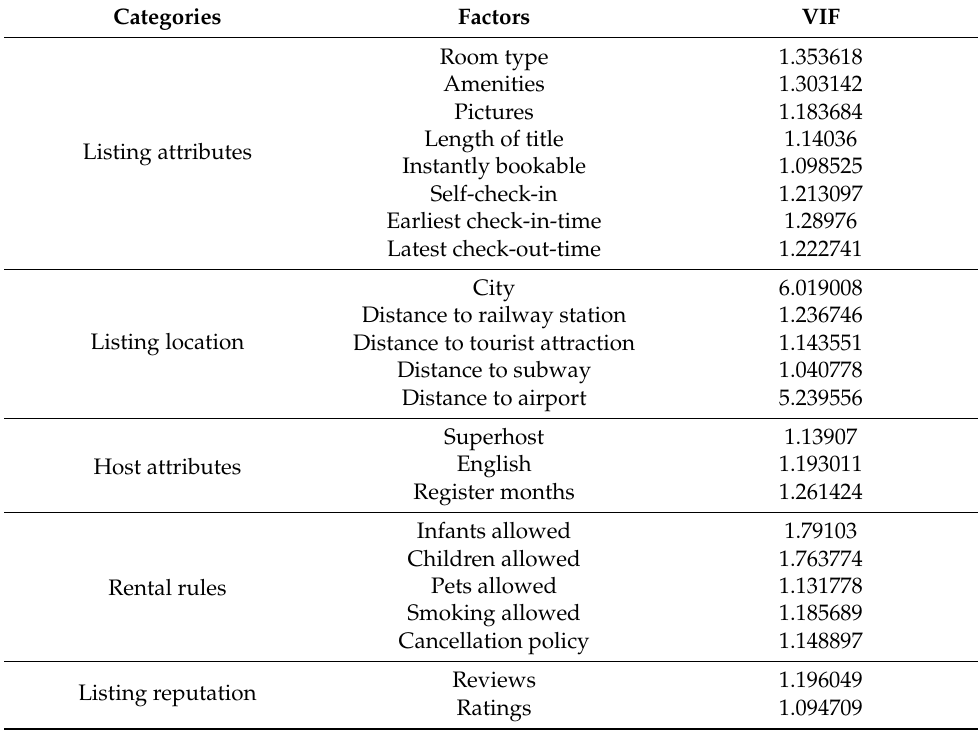
Table 3. Variance inflation factor (VIF)